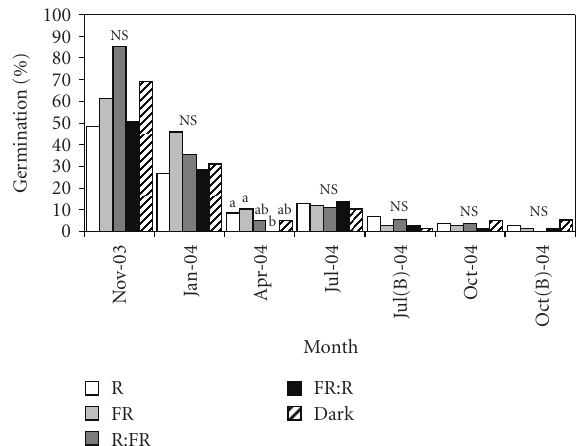
Figure 1: Senna obtusifolia percentage germination in response to light environment with after-ripening following maturation in late October 2003. One half of the S. obtusifolia seeds were buried in soil 10cm deep in Spring 2004; therefore, Summer and Fall evaluations included seeds from the soil surface and buried ones. Abbreviations: B: buried; FR: far-red light; NS: nonsignificant; R: red light. Means with di ff erent lowercase letters within a month and burial depth are significantly di ff erent at α = 0 . 05.